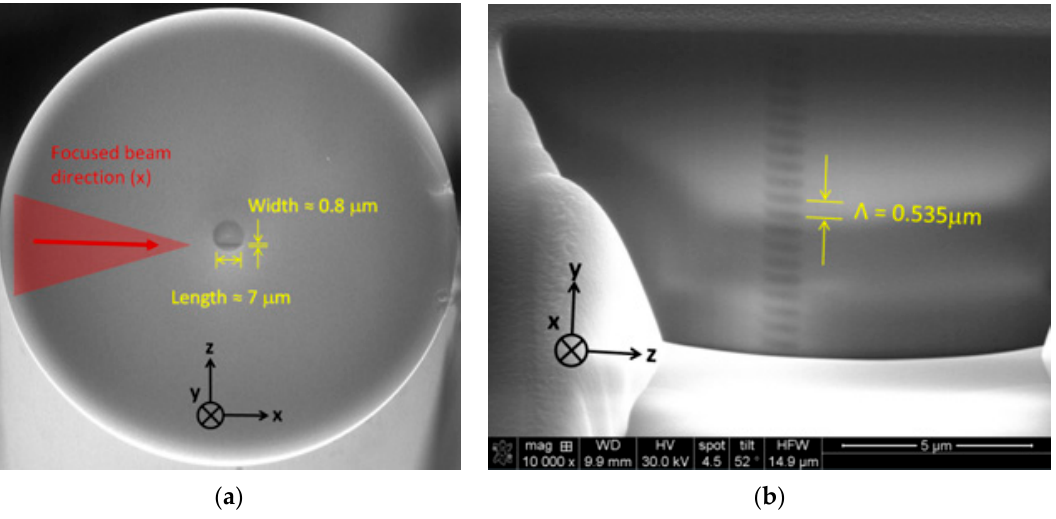
Figure 2. Scanning electron microscope ( SEM) image of: ( a ) the cleaved fiber cross section; and ( b ) longitudinal view of the grating pattern, both for a static exposition of 60 s at 75 µJ of energy. The laser beam used was Gaussian, with d ~11 mm. The fiber is an unloaded SMF-28.